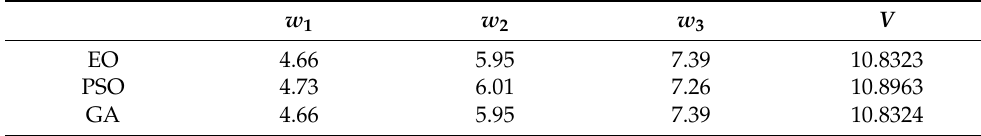
Table 3. Allocated tasks for the AUVs and the value of the goal function in the small-scale system.